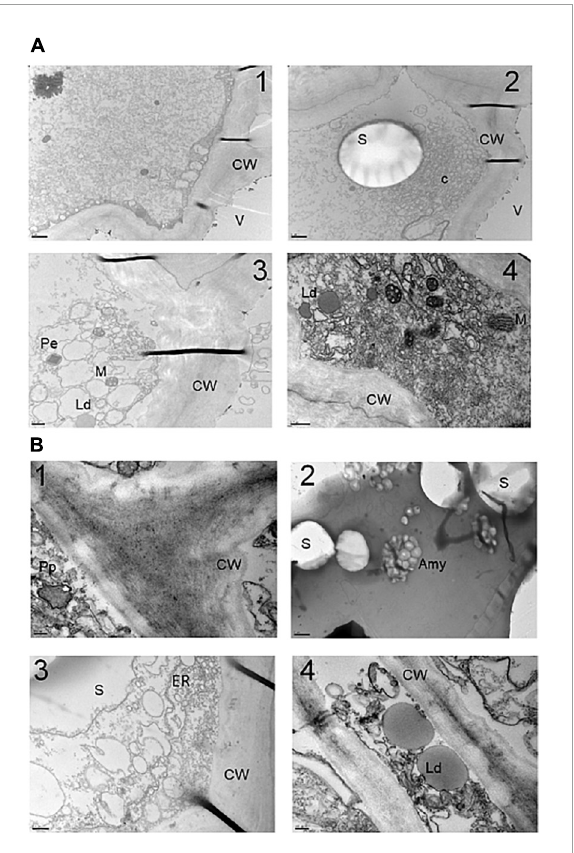
FIGURE3 Transmission electron microscopy (TEM) of storage parenchyma cells of potato tubers. (A) TEM images of wild type (WT) simples. (B) TEM images of transgenic O6 line. Amy, amyloplast; C, clusters of amyloplast protusions; Cw, cell wall; Ld, lipid droplet; M, mitochondria; Pp, proplastid; Pe, peroxisome; ER, endoplasmic reticulum; V, vacuole; S, starch. Scale bars in panels (B1,4) are 200 µ m, in panel (B2) is 2 µ m, in panels (A1,2) are 1 µ m, and in panels (A3,4,B3) are 0.5 µ m.